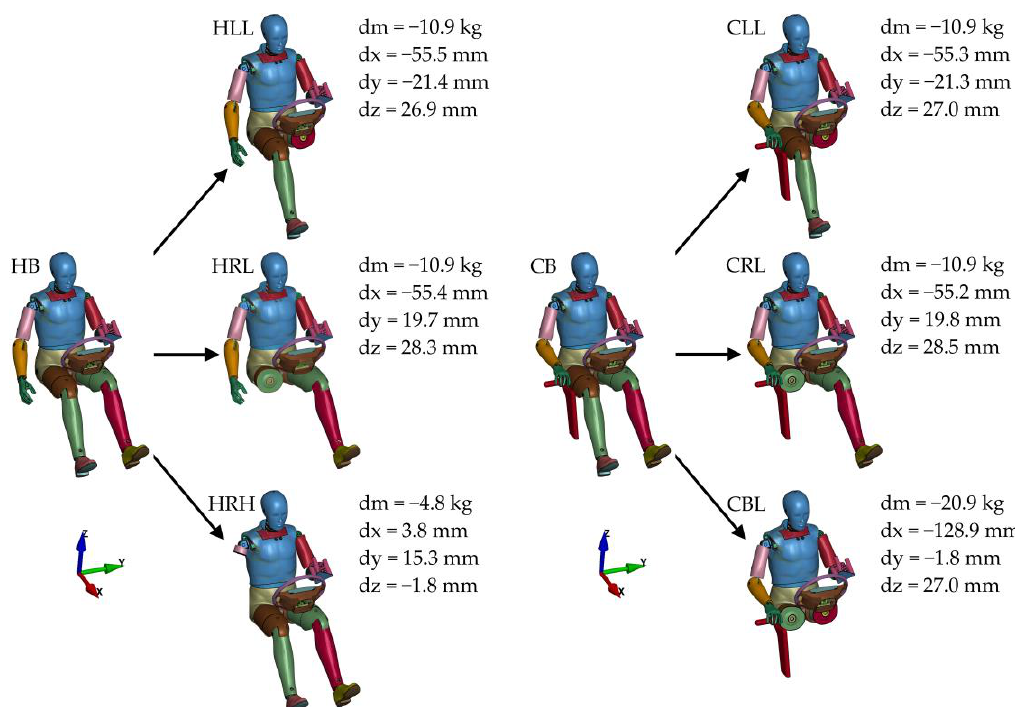
Figure 5. Second stage of dummy model modifications.